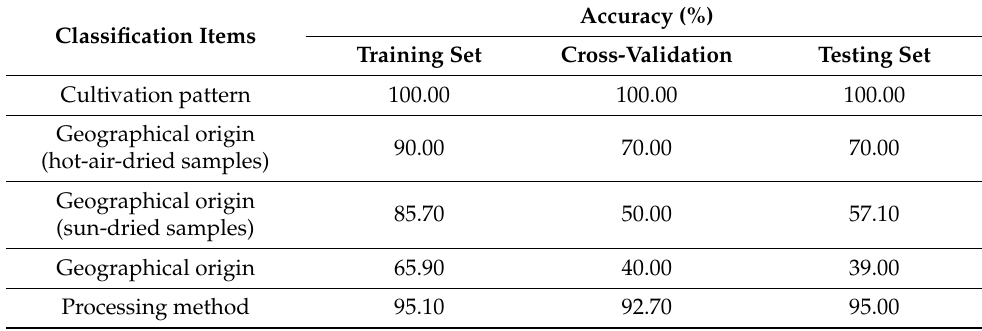
Table 3. Accuracy of LDA models based on 6 bioactive compounds.